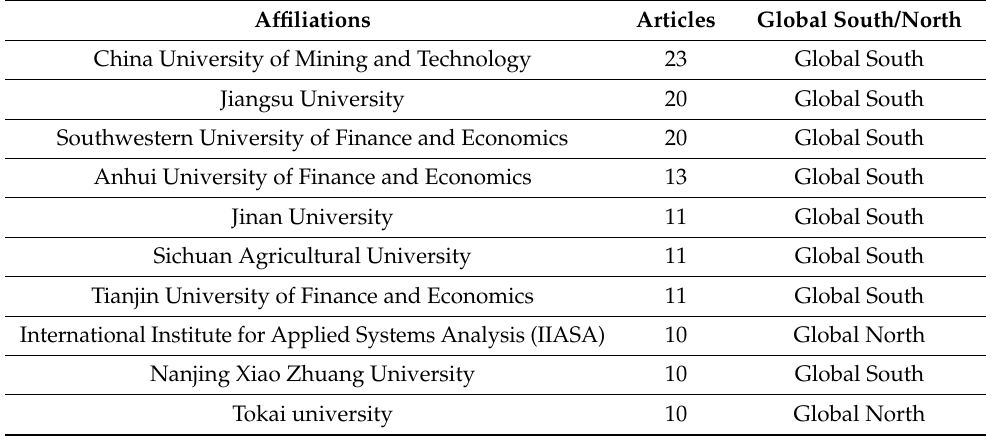
Table 7. Frequency of affiliations.